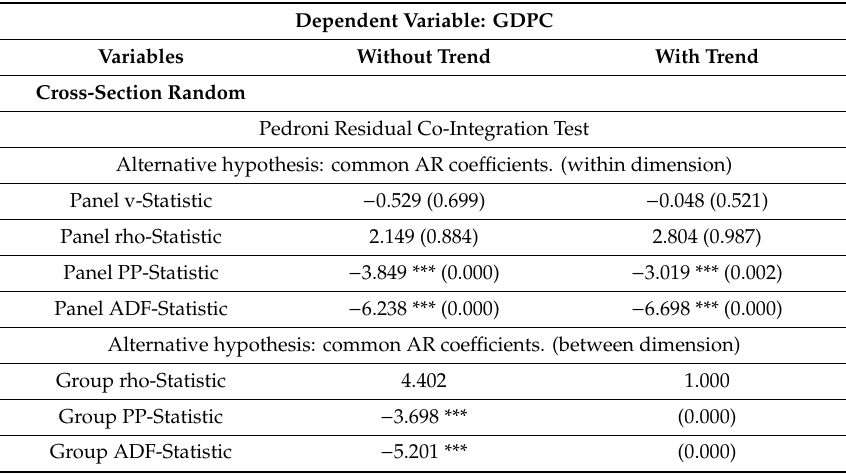
Table 6. Panel Co-Integration Test results for the EU member states in 2004–2017.